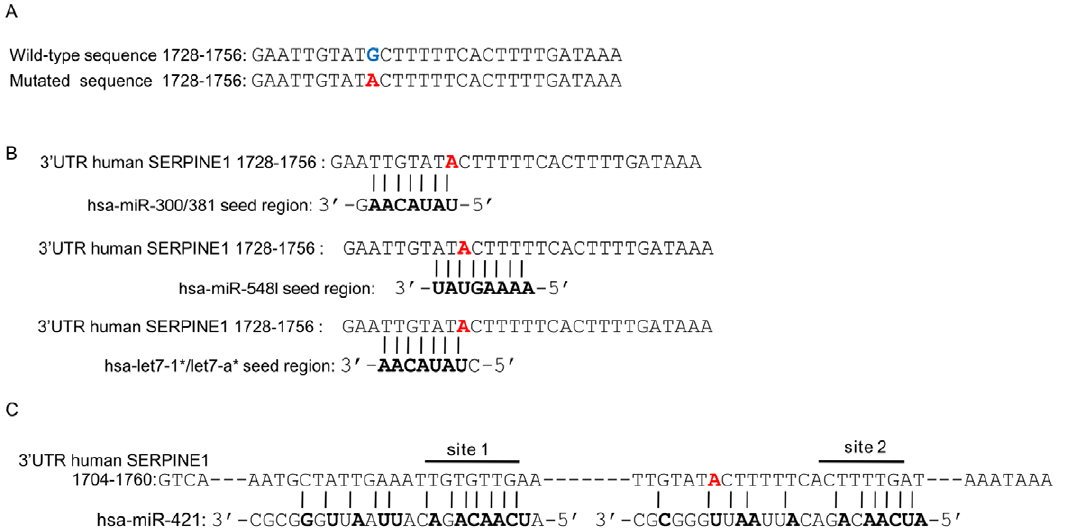
Figure 1. miRNA binding sequences in the SERPINE1 3 9 UTR region. The 3 9 UTR human SERPINE1 sequence is 1841 bp long. The rs1050955-A muted allele is shown in red bold. A. SERPINE1 DNA sequence showing the rs1050955 G/A polymorphism in position 1737. B. Representation of various miRNA seed region and their complementary sequence in SERPINE1 3 9 UTR 1728–1756 region. C. Alignment of miR-421 onto SERPINE1 3 9 UTR 1704–1760 region which includes two predicted binding sites, site 1 and site 2, complementary to the miR-421 seed sequence.